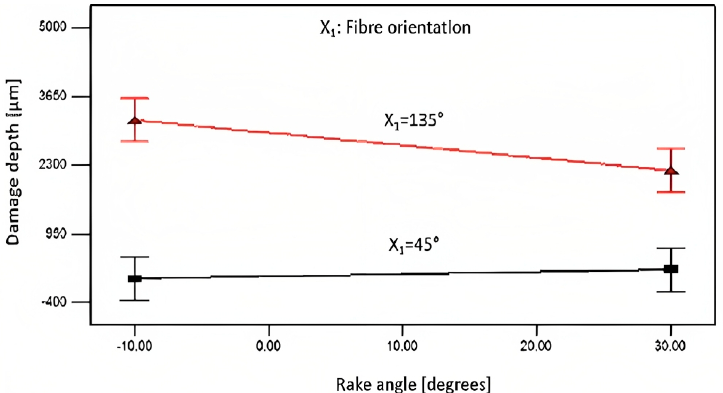
Figure 15. Effect of fibre orientation and tool rake angle on the depth of cut of 100 µm and V c = 570 mm/min. Trial No. DOC = 50 µm DOC = 100 µm DOC = 150 µm